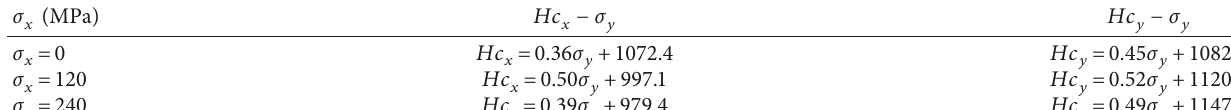
Table 2: Hc − σ y fitting formula under different σ x of test piece 2.